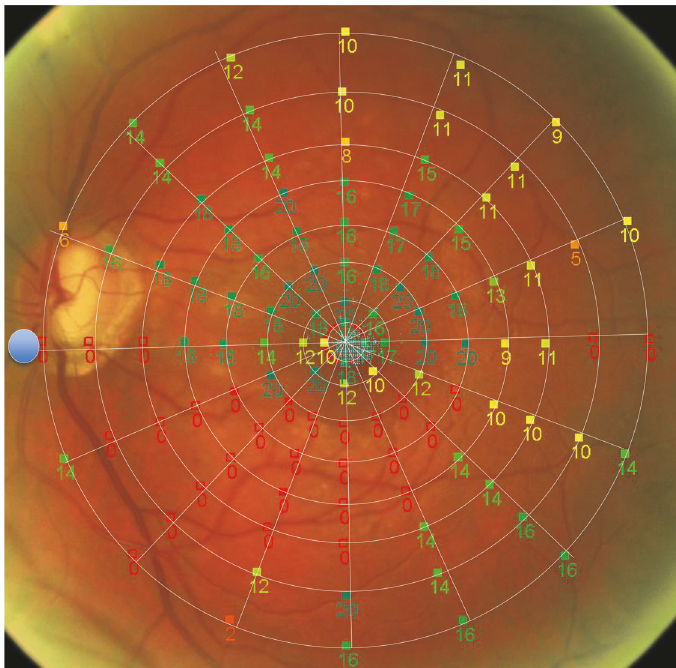
Figure 1: Custom-made macular visual fi eld (VF) pattern with 108 testing points by microperimetry testing retinal sensitivity (example of a left eye).